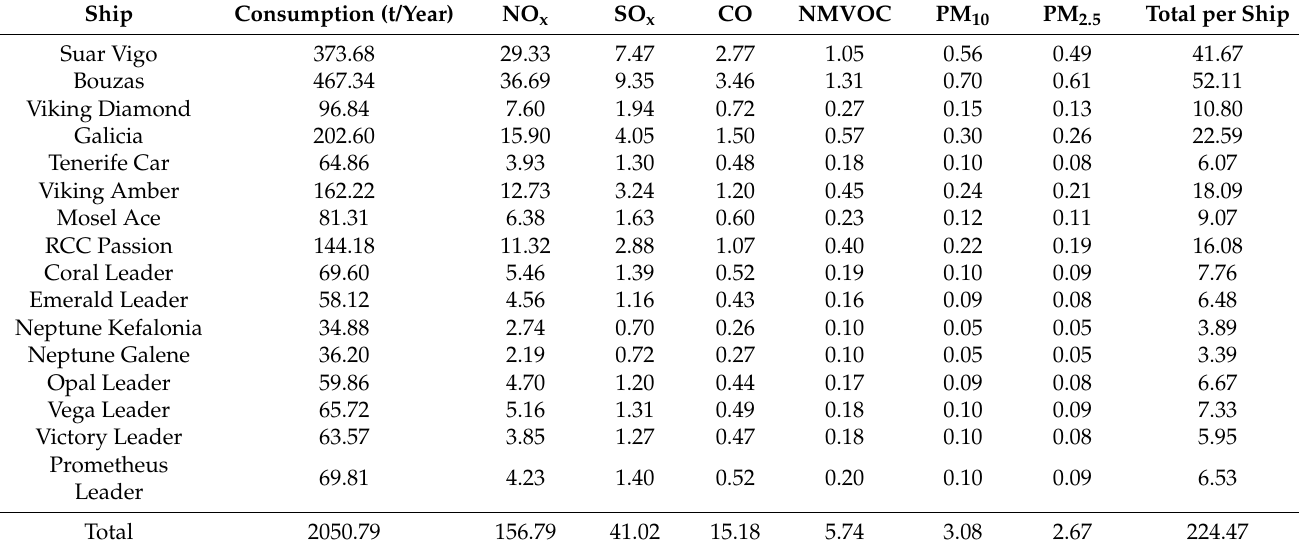
Table 13. Emissions (t/year) estimation from MDO/MGO fuel